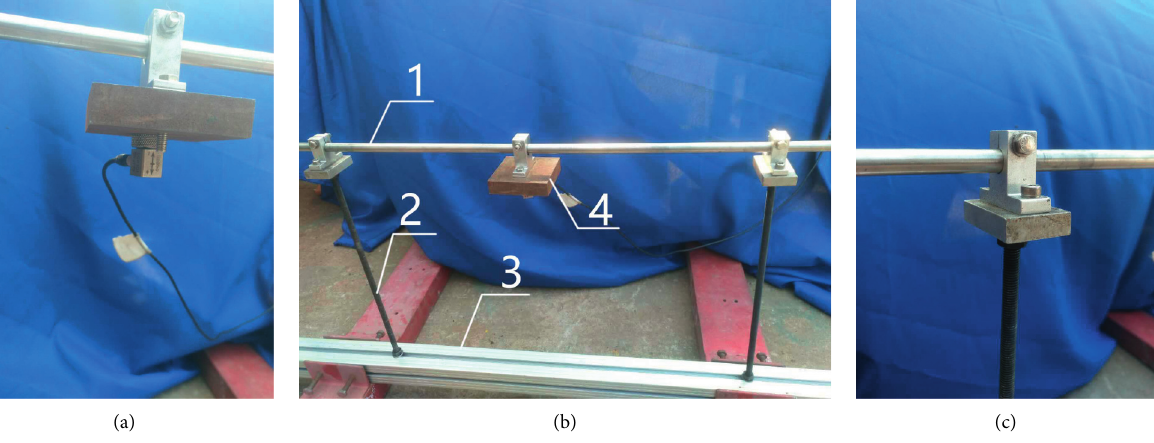
Figure 6: Photos of the FATMD (1—beam; 2—column; 3—bottom plate; and